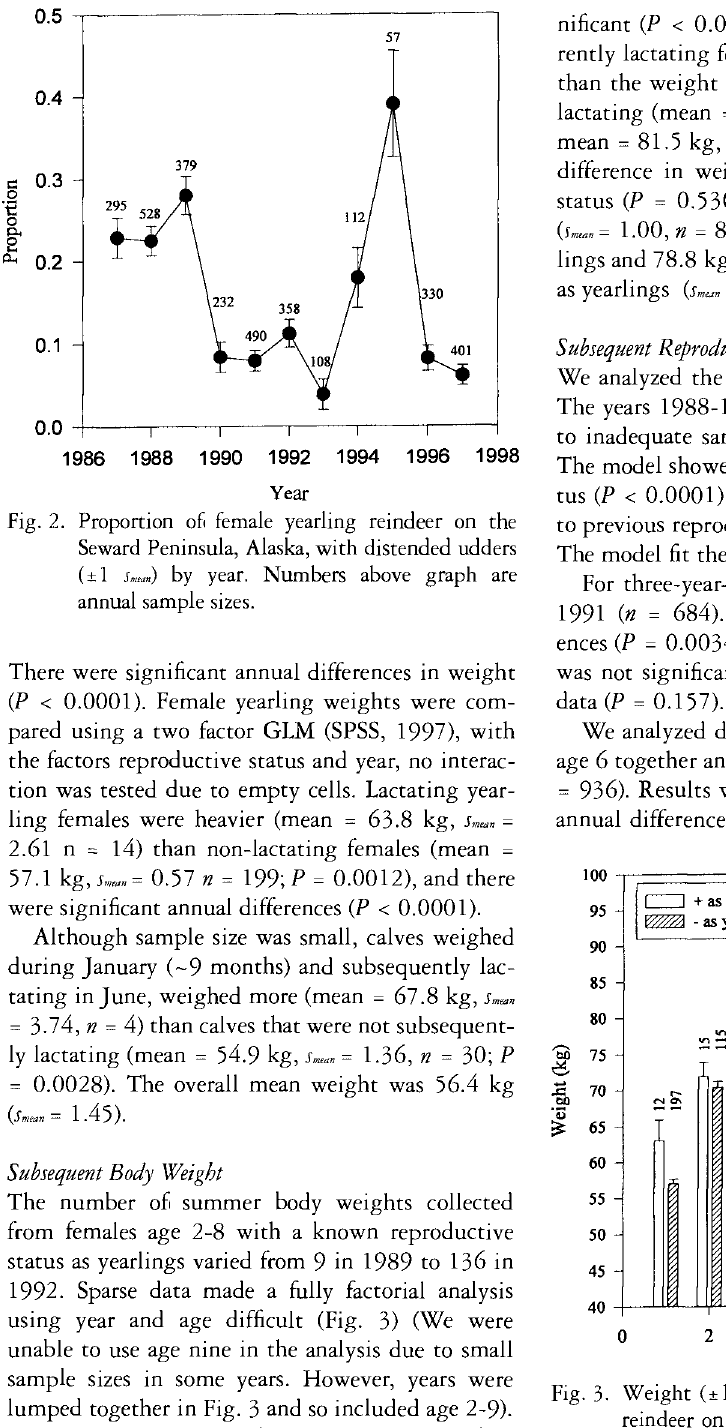
Fig. 3. Weight (±1 s,„„) as a function of age for female reindeer on the Seward Peninsula, Alaska. Open bars represent female reindeer with distended udders as yearlings and hatched bars represent females that did not have distended udders as yearlings. Numbers above bars are sample